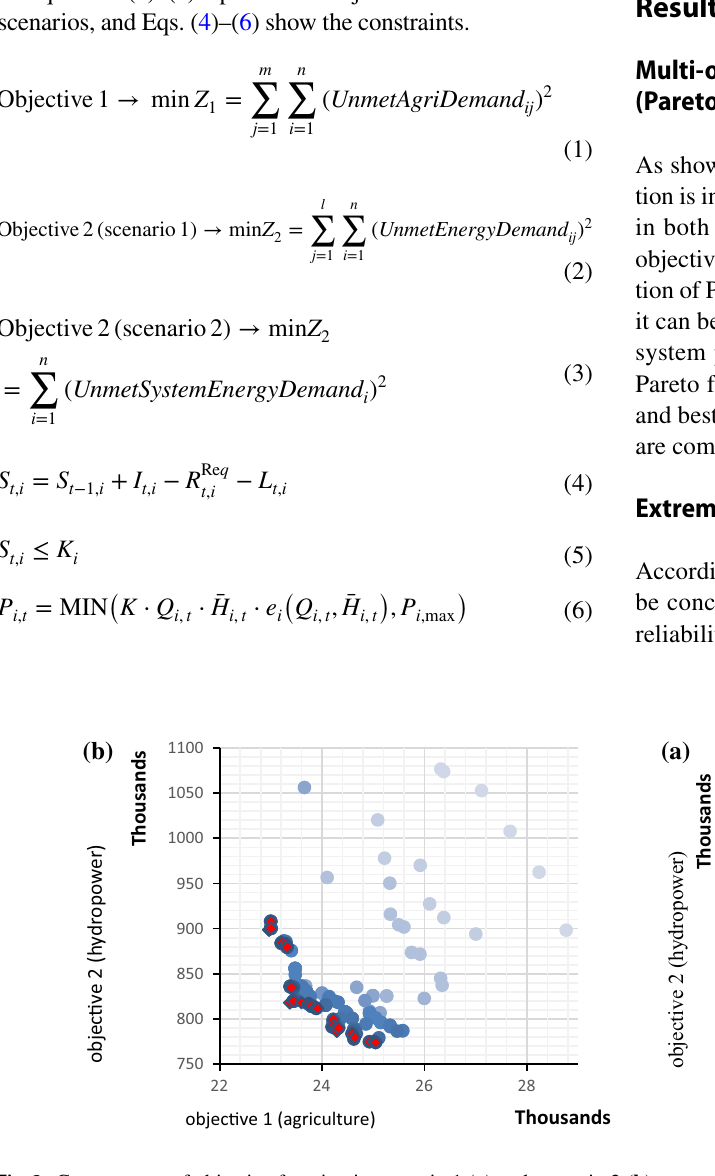
Fig. 3 Convergence of objective function in scenario 1 ( a ) and scenario 2 ( b